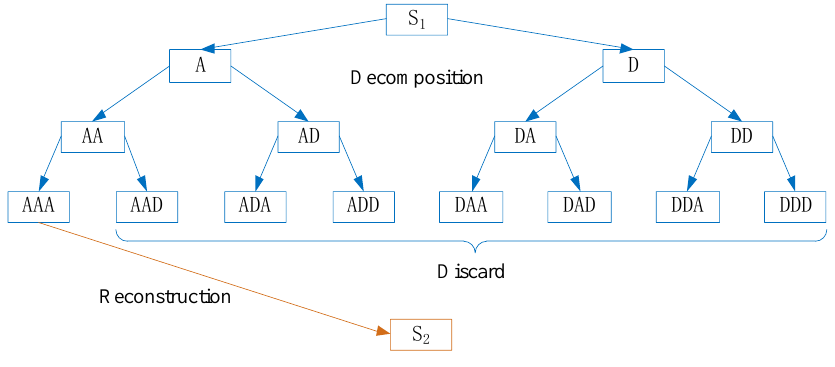
Figure 1. Decomposition and reconstruction of WPT sub-algorithm.